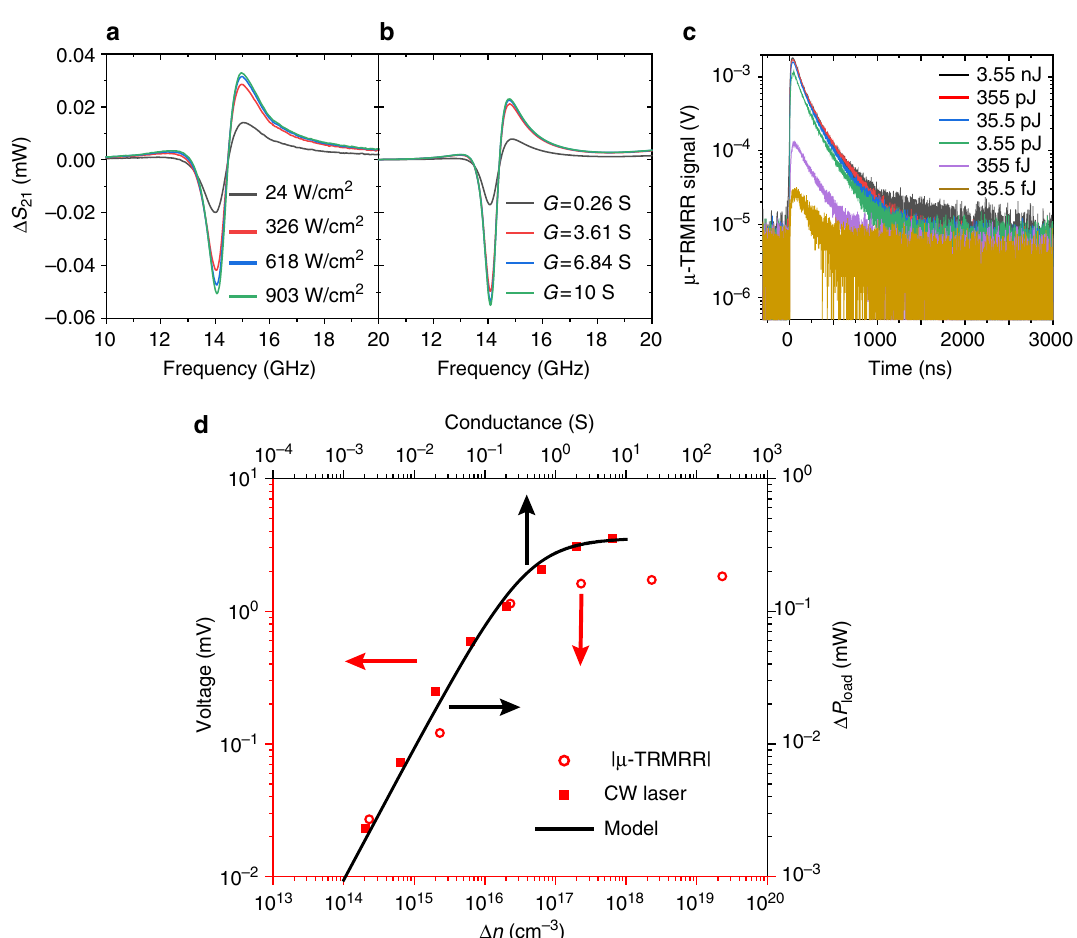
Fig. 4 Linearity of the presented technique. a Measured Δ S 21 (the change in the S 21 parameter when light is incident upon the pixel) for varying CW laser excitation at room temperature, b modeled Δ S 21 as a function of pixel conductance, and c measured room-temperature µ -TRMRR signal as a function of energy incident upon the pixel. d | Δ S 21 | on resonance from CW response shown in a , (red squares), and peak | µ -TRMRR| signal shown in c (red circles) as a function of excess carrier concentration and modeled | Δ S 21 | (black, solid) as a function of conductance, from